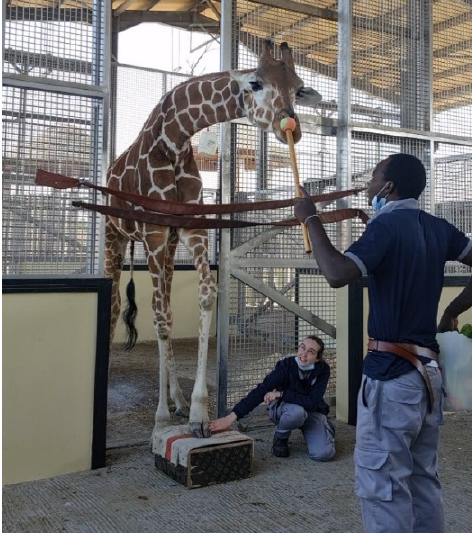
Figure 1. The Protected Contact set-up for giraffe footcare at Dubai Safari Park.